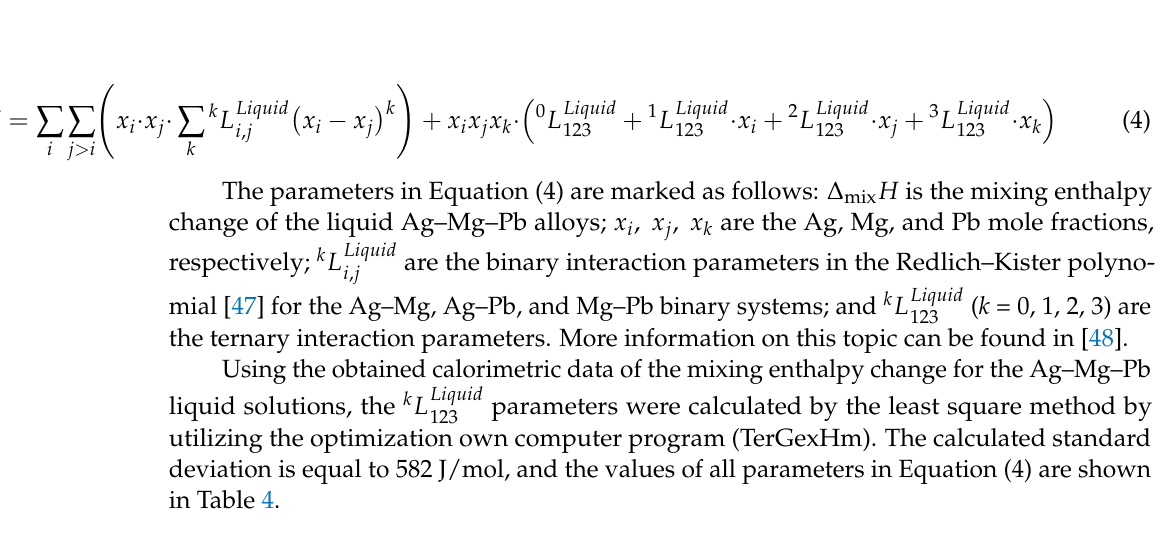
Table 4. The binary k L Liquid